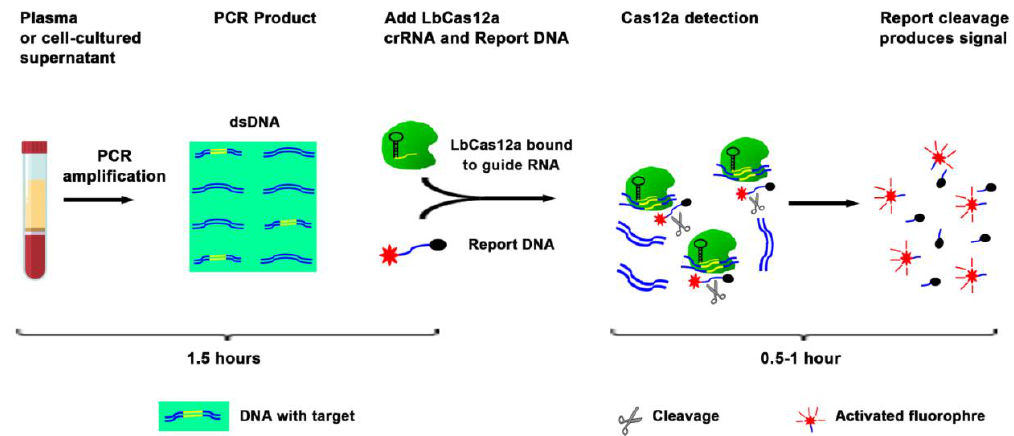
Figure 2. Overview of the CRISPR-Cas12a system to directly target plasma for the detection of EGFR mutations. Plasma or supernatant of cultured cells were processed for simply PCR amplification. The PCR product was a mixture with LbCas12a, crRNA, and ssDNA FQ reporter. The reaction was proceeded for up to two hours at room temperature on a plate reader for fluorescent readout.